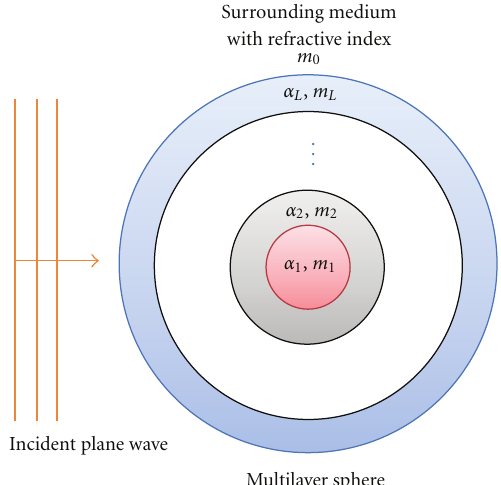
Figure 1: Multilayer sphere model with L layers and zero indexed environment parameters. A plane electromagnetic wave is coming from the